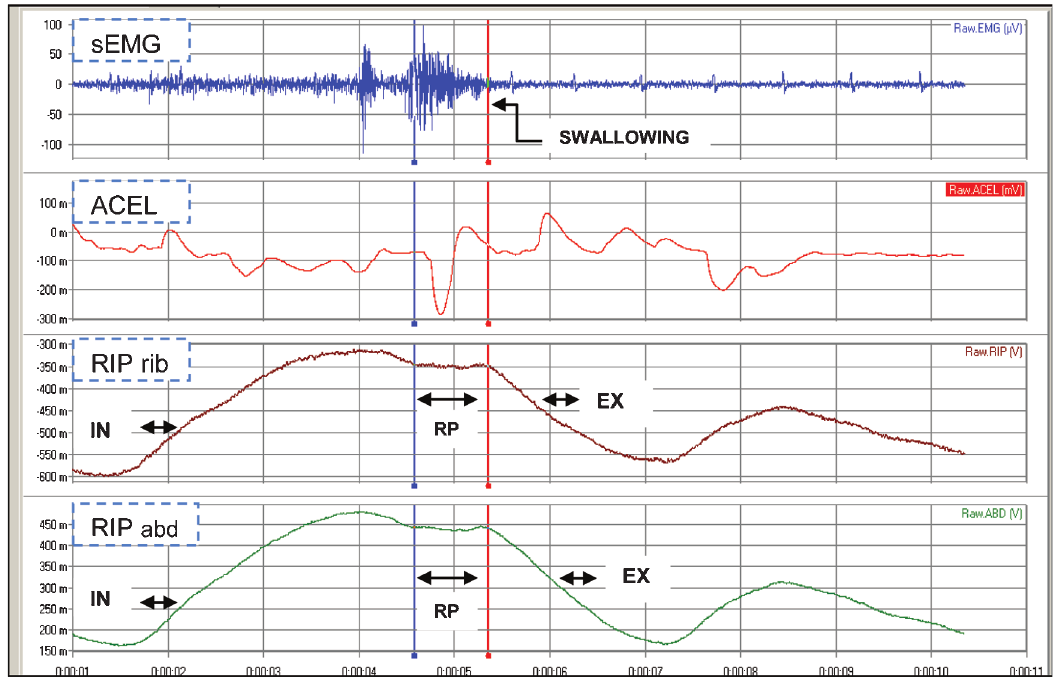
Figure 1 - Graphical depiction of the signals that were obtained from surface electromyography (sEMG), accelerometry sensor (ACEL), and inductive respiratory plethysmography (RIP) measurements in patients who swallowed 10 mL of water. Notes: Respiratory phases: inspiration (IN), expiration (EX), respiratory pause (RP), plethysmography rib cage (RIP rib), and plethysmography abdomen